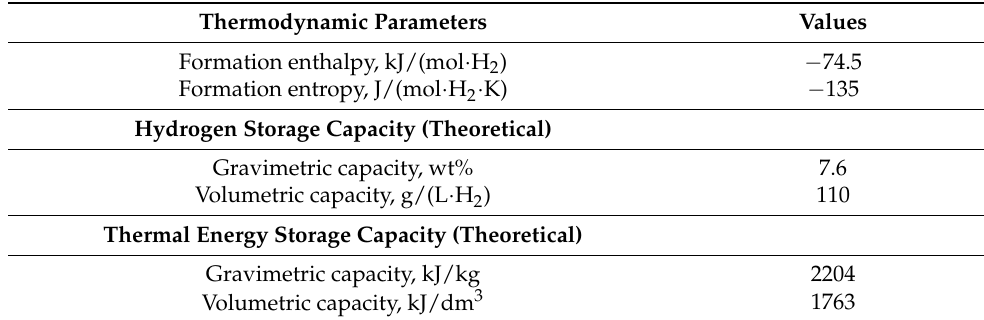
Table 2. Thermodynamic parameters and energy storage properties of MgH 2 [26].